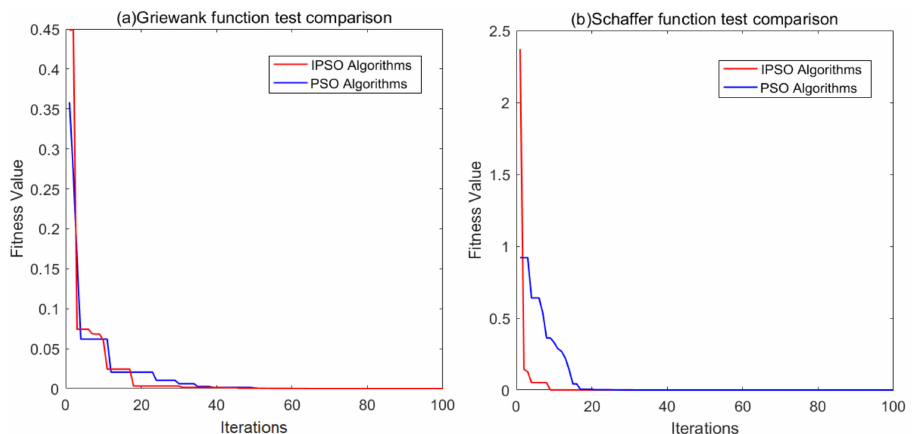
Figure 6. Performance comparison of PSO and IPSO algorithms.